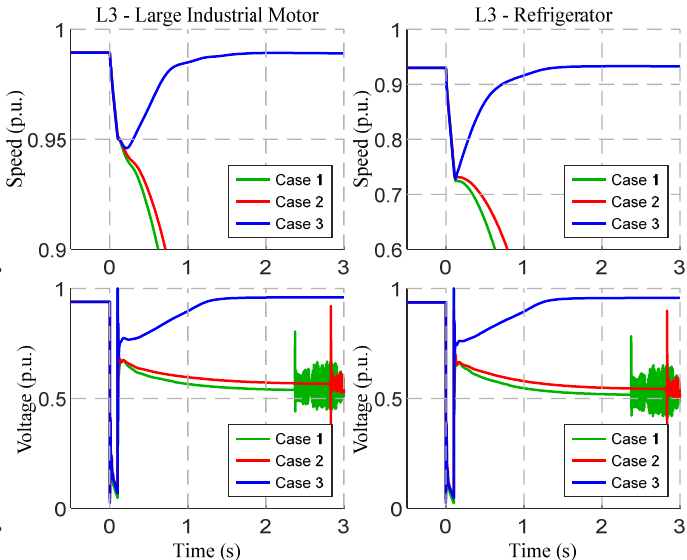
Figure 19. L3 large industrial motor (left) and refrigerator load type motor (right) speeds and terminal voltages for different reactive current-voltage injection profiles adopted in CI-RES.